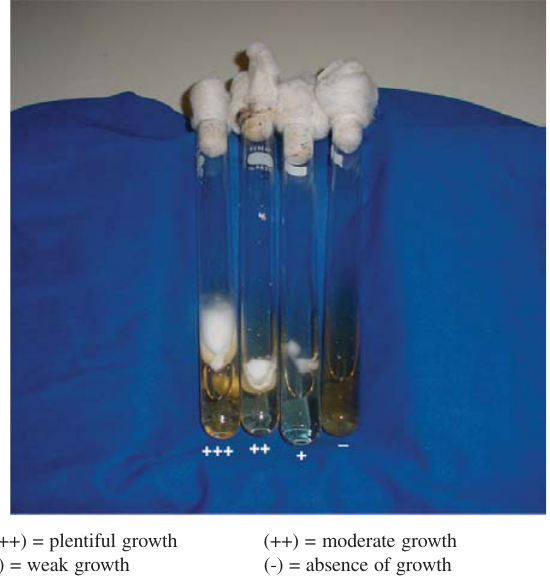
Figure 1 - Illustration of the classification scheme of growth patterns of dermatophytes during the incubation of the samples in the presence or absence of